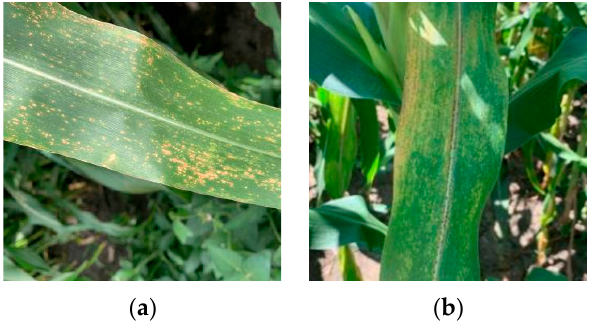
Figure 1. Diseased corn leaves. ( a ) Anthracnose; ( b ) Brown spot.